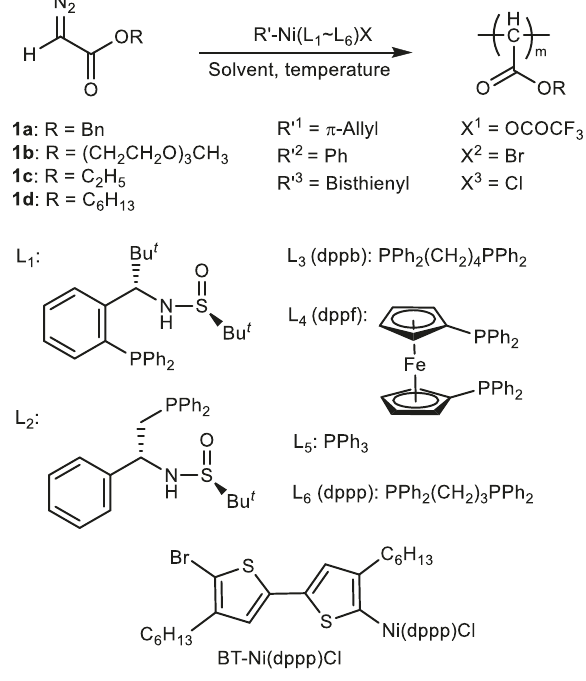
Fig. 1 Reaction scheme. Polymerization of monomer 1a – 1d using R ′ – Ni(L 1 – L 6 )X (L =